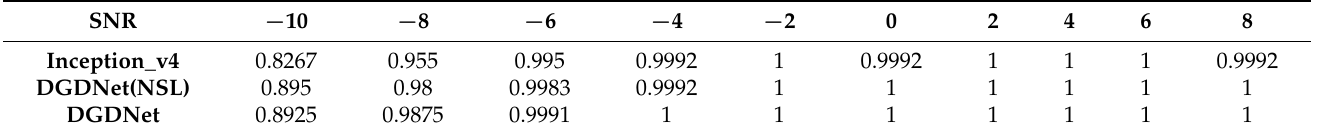
Table 3. Detailed indicators of three